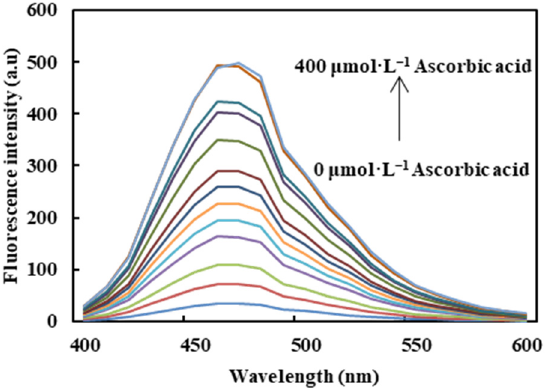
Figure 8. The effect of ascorbic acid concentration on the fluorescence intensity of the CDs/Fe 3+ composite.